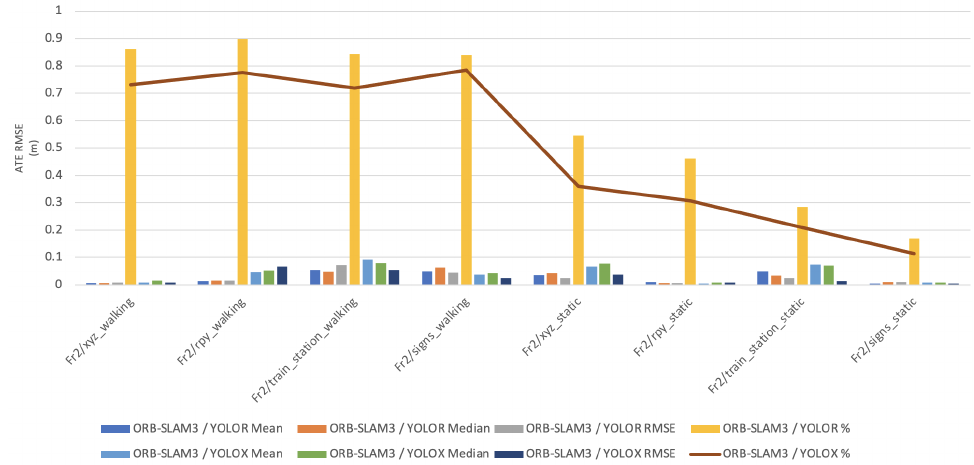
Figure 13. Absolute Trajectory Error (RMSE) distribution of ORB-SLAM3/YOLOR—ORB-